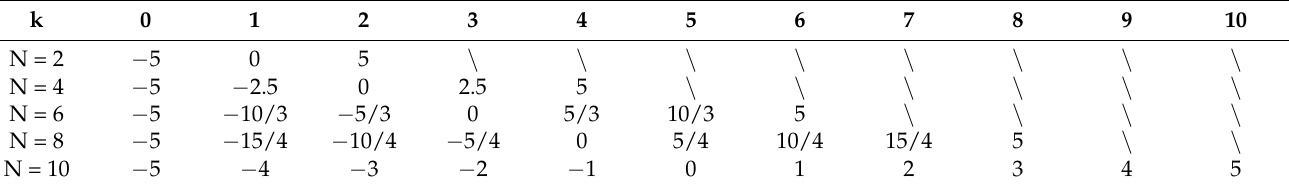
Table 1. The corresponding value of the independent variable of HTF.